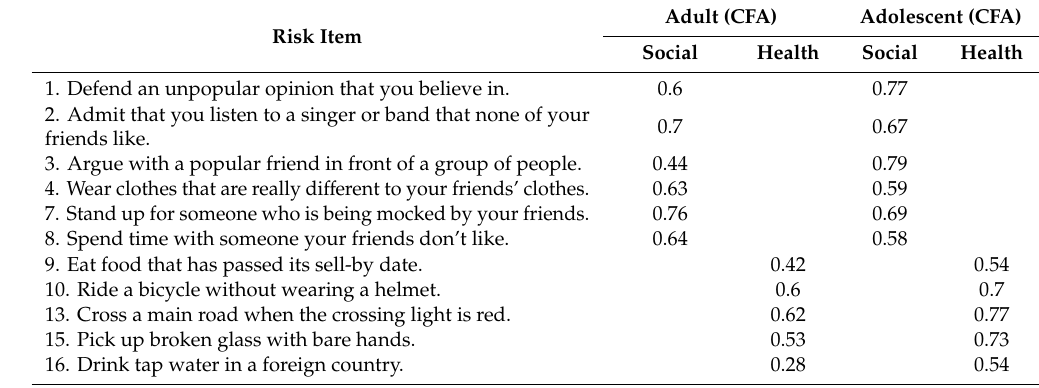
Table 2. Item loadings from the confirmatory factor analysis (CFA) in both the adult and adolescent sample.